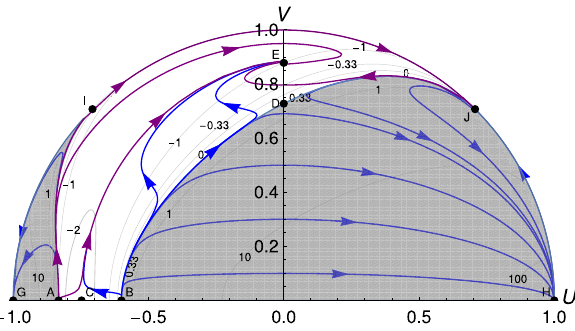
Fig. 11 Thephaseportraitofsystem(25)onthePoincarésphereforthe generic scenario (a). Values of parameters are ξ = 3 , n = 2, ε = + 1. 16 Purple arrows denote orbits corresponding to the evolution from the w φ = − 1 equilibrium A to the w φ = − 1 equilibrium E , while the blue arrows denote other orbits. Light grey contours correspond to values of the equation of state parameter w φ . The shaded region is non-physical